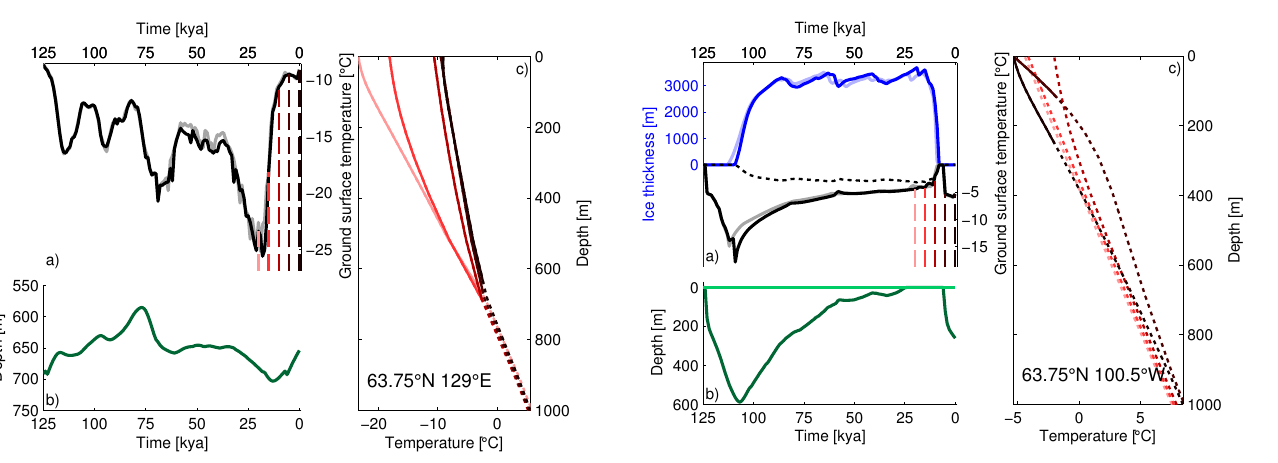
Figure 12. Evolution of ground surface temperature and ice thick- ness (a) , base of permafrost layer (b) and ground temperature pro- files since LGM (c) in central Siberia at the location with co- ordinates indicated in (c) . In (a) the ground surface temperature (solid black line) evolution over the last glacial cycle is shown. The surface temperature (grey) evolution in the simulations with zero porosity is also shown for comparison. The red vertical lines indi- cate the times at which the ground temperature profiles are plotted in (c) . In (b) the evolution of the depth of the base of the permafrost layer is presented (dark green). (c) shows the ground temperature profiles at selected times since the LGM as indicated in (a) . Solid lines represent permafrost while dotted lines indicate no permafrost. The color code of the red lines in (a) and (c) corresponds to each other.